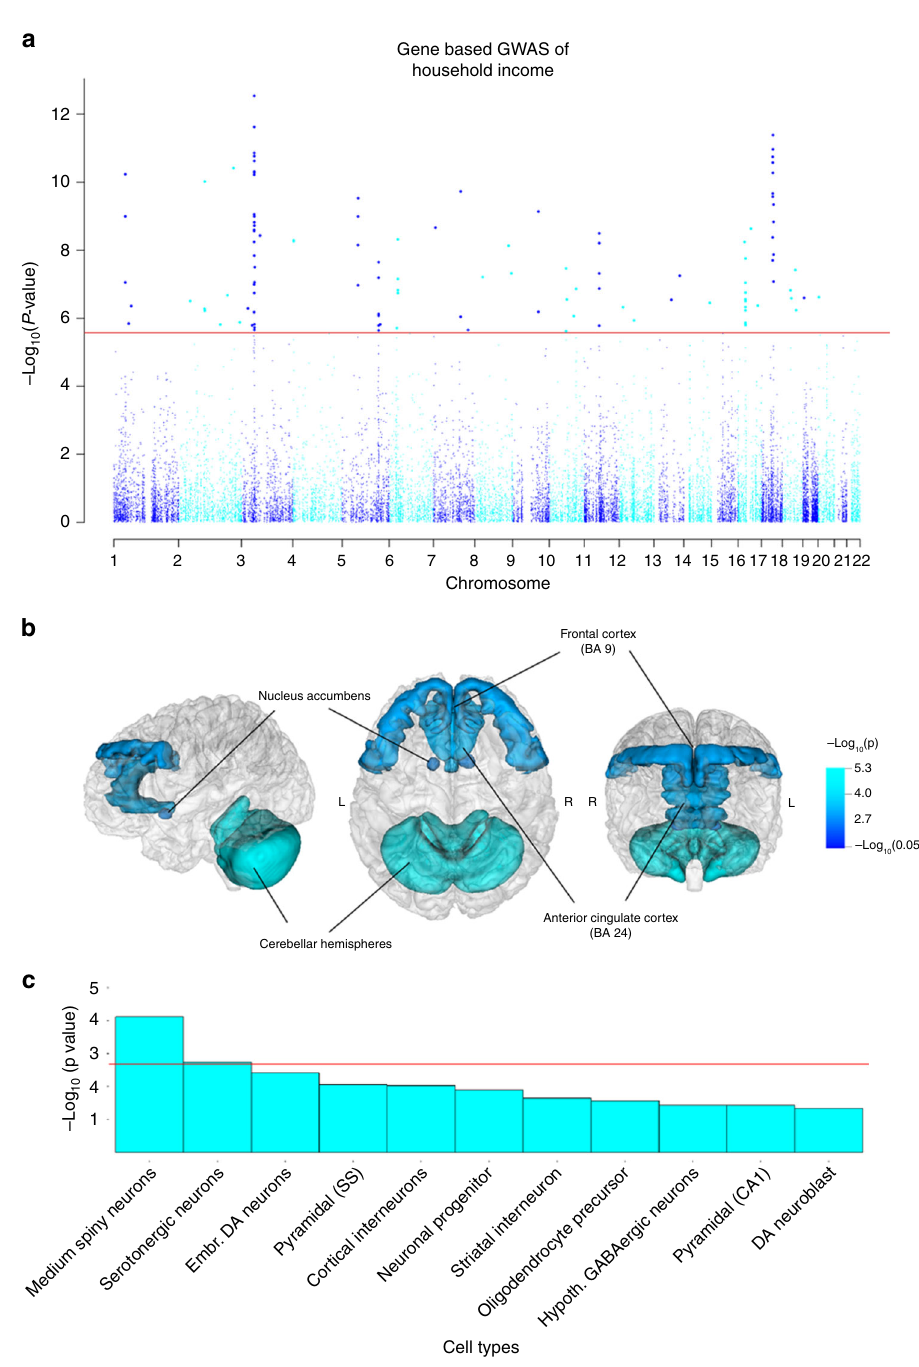
Fig. 4 Gene-level associations for income and links to transcription in the brain and cortical cell types. a A Manhattan plot of income using the gene- based statistics derived using MAGMA; – log 10 -transformed P values for each gene are plotted against chromosomal location. The red line indicates genome-wide signi fi cance. b The results of a gene-property analysis linking transcription differences in the brain with income differences. Signi fi cant links between expression differences in cerebellar hemisphere, at Brodmann area 9 (BA9) of the frontal cortex, the nucleus accumbens and at Brodmann area 24 of the anterior cingulate cortex (BA24) are illustrated. Dark blue indicates low – log 10 P values (a lower level of association) describing the link between gene expression and household income and light blue indicates high – log 10 P values (a higher level of association) describing the same relationship. The full results are found in Supplementary Data 8 with the gene-based statistics produced using MAGMA. c shows the results of a cell-type-speci fi c gene- property analysis where the relationship between the gene-based statistics from MAGMA and the degree to which gene expression was speci fi c to the annotations was examined. A Bonferroni correction was applied to control for the 24 tests conducted. The red line indicates statistical signi fi cance indicating that expression that is speci fi c to the annotation is associated with the gene-based statistics for income. Embr. DA Neurons, Embryonic Dopaminergic Neurons; Pyramidal (SS), Pyramidal (Somatosensory); Hypoth. GABAergic Neurons, Hypothalamic GABAergic Neurons; DA Neuroblast, Dopaminergic